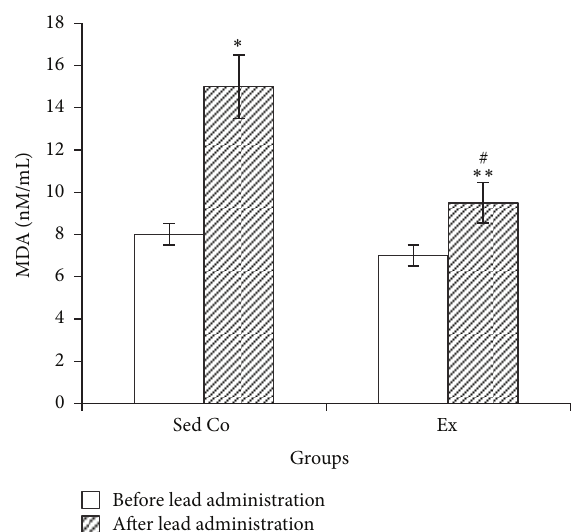
Figure 4: Blood malondialdehyde in sedentary control and exercise groups before and after lead administrations. Seven days of lead injections (15mg/kg body weight, ip) to the both sedentary and exercising animals caused significant raise of blood MDA ( ∗ 𝑃 < 0.05 compared to the “before lead administration” in Sed Co group, ∗∗ 𝑃 < 0.05 compared to the “before lead administration” in Ex group); in Ex animals MDA levels after the lead administrations were significantly lower than the Sed Co lead-injected animals ( # 𝑃 < 0.05 compared to the “after lead administration” in the Sed Co group). The data are presented as means ± S.E.M. MDA: malondialdehyde; Sed Co: sedentary control group; Ex: exercise group.